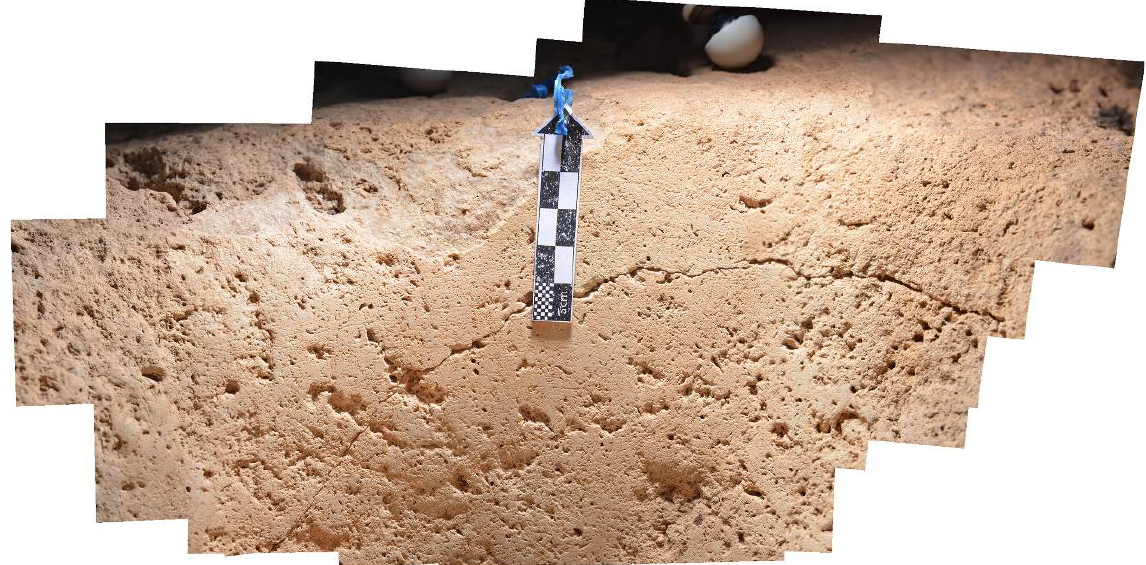
Figure 8. A panoramic view of the top of the shaft, mortar C-XVIII. The smooth area above and below the horizontal crack is the richest in terms of preserved patterned incisions (Scale is 5 cm, photograph by E. Crater